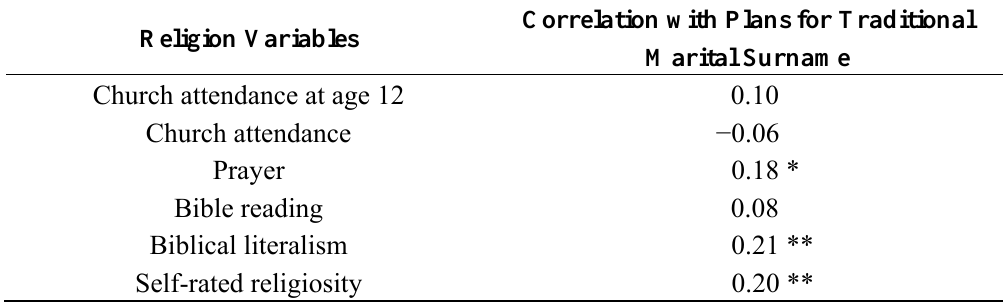
Table 2. Religious Influences on Plans to Follow Traditional Marital Naming